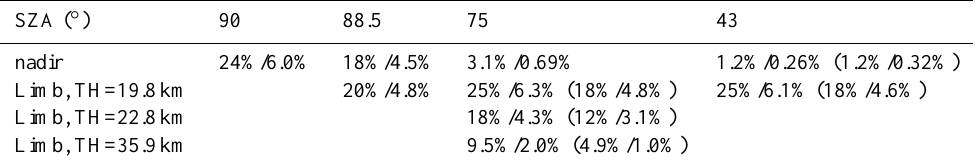
Table 2. Variation of AMFs of ozone in the wavelength range of 332–357nm for different observation geometries and ozone profile with VCD of 460DU (in brackets values for the scenario with VCD of ozone of 200DU are given). The first number gives the difference between maximum and minimum values of AMFs normalized by the mean of AMFs in the wavelength range; the second number is the standard deviation. Calculations are performed only for selected geometries and SZAs in order to illustrate the general